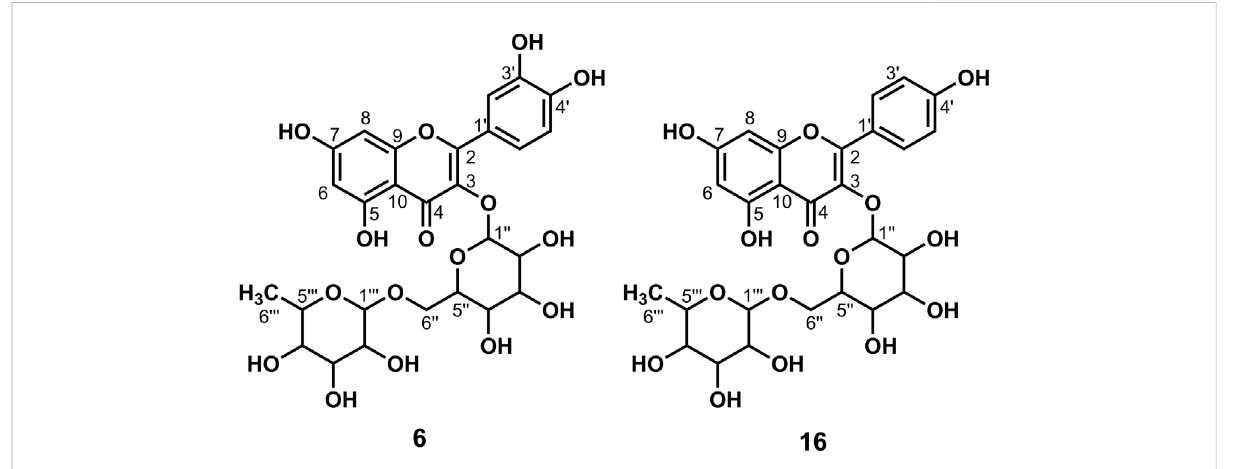
FIGURE 3 Chemical structure of compounds 6 and 16